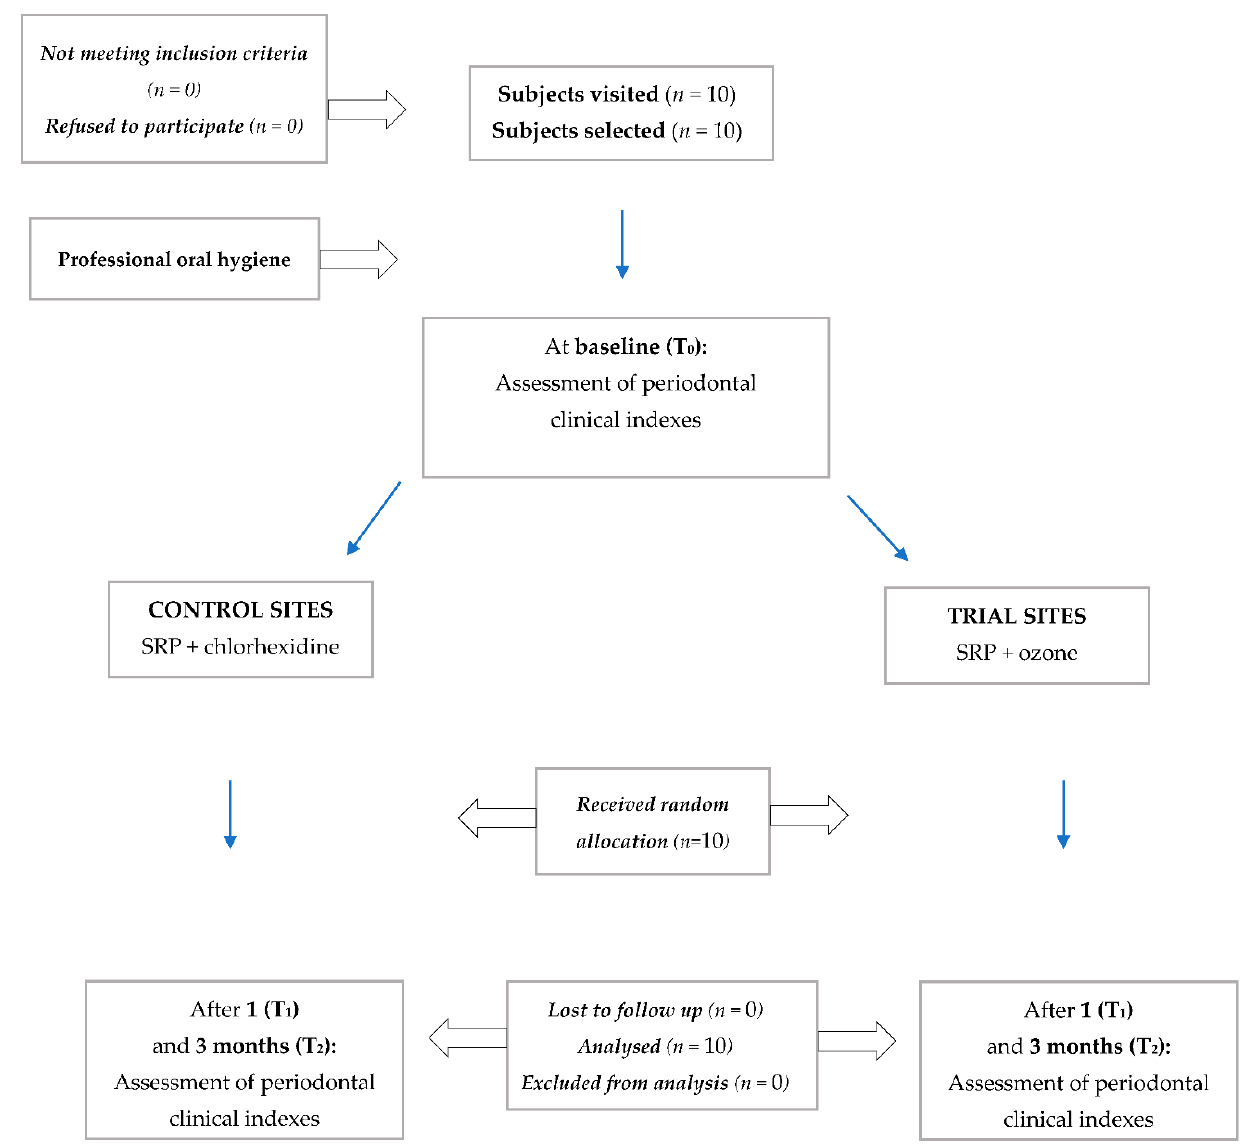
Figure 1. Flow-chart of the study.